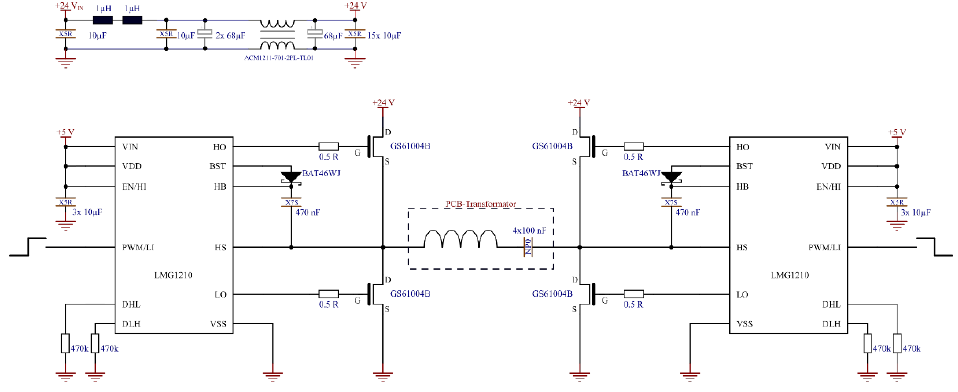
Figure 3. Circuit diagram of the control electronics for the transformers.